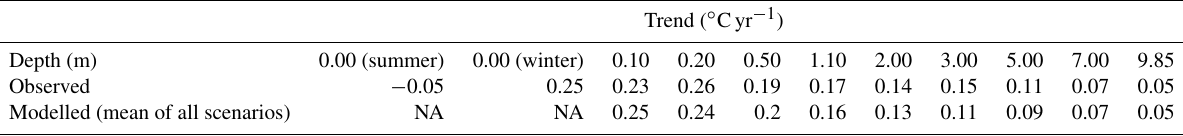
Table 6. Subsurface temperature trends [ ◦ Cyr − 1 ] as recorded and modelled (mean of all scenarios). Trends in the active layer (down to 1.1m depth) are calculated for the period September 2000–August 2014, and trends in the permafrost (from 2.0 to 9.85m depth) for the period September 2008–August 2014. Summer is here defined as the period of continuous positive temperatures during the thaw season and winter as the remaining part of the year.